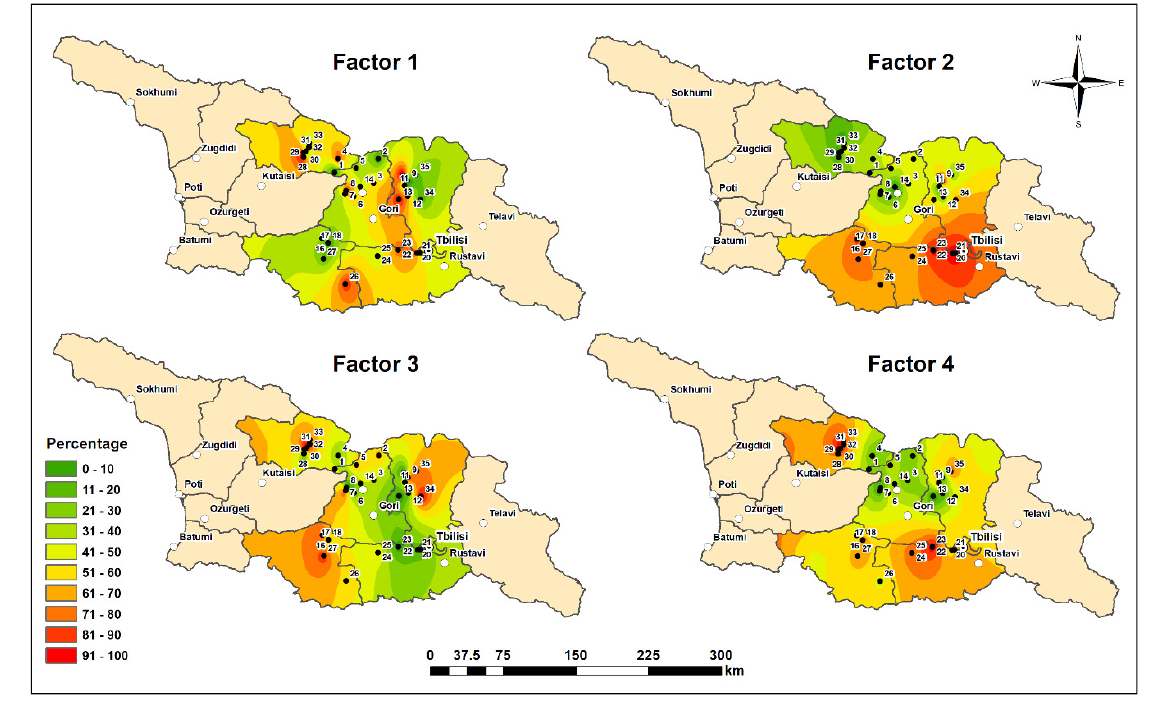
Figure 5. Factor Scores.